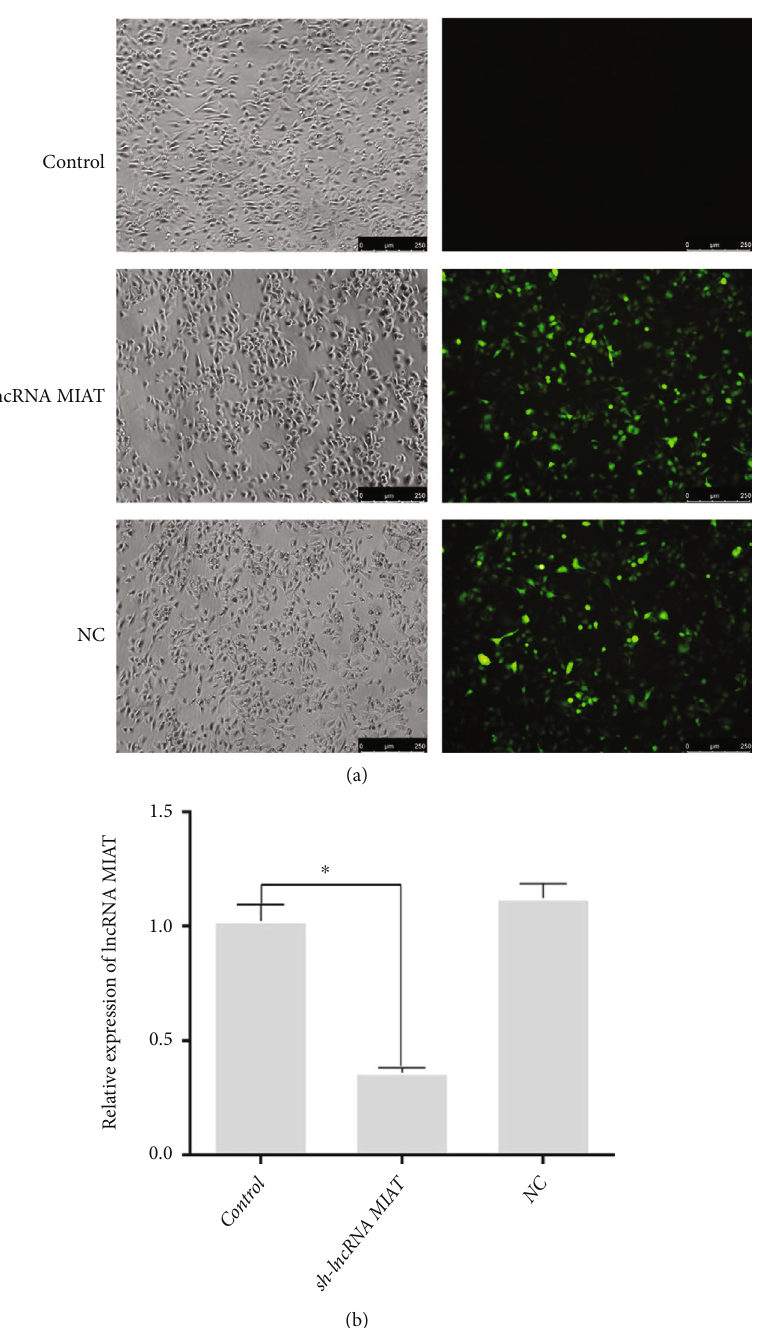
Figure 2: sh-lncRNA MIAT lentivirus infection and e ffi ciency identi fi cation. (a) sh-lncRNA MIAT infection. (b) E ffi ciency identi fi